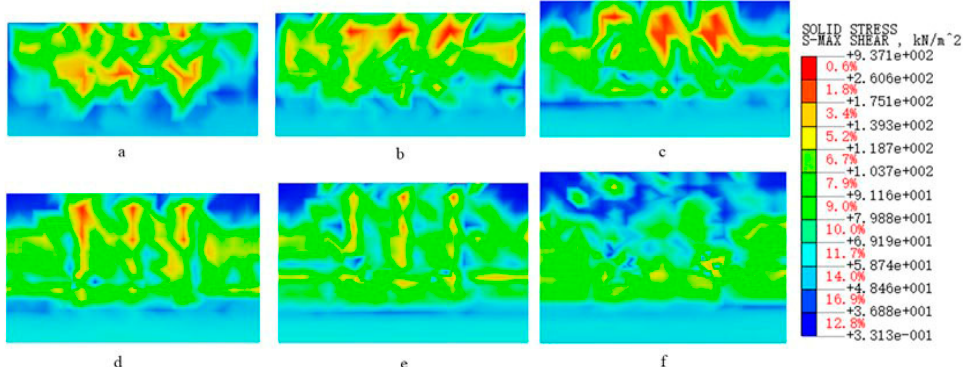
Figure 15. The shear stress of the soil at the 3 m root slope section: ( a ) The slope toe, ( b ) The second row, ( c ) The third row, ( d ) The fourth row, ( e ) The fifth row, ( f ) The sixth row.